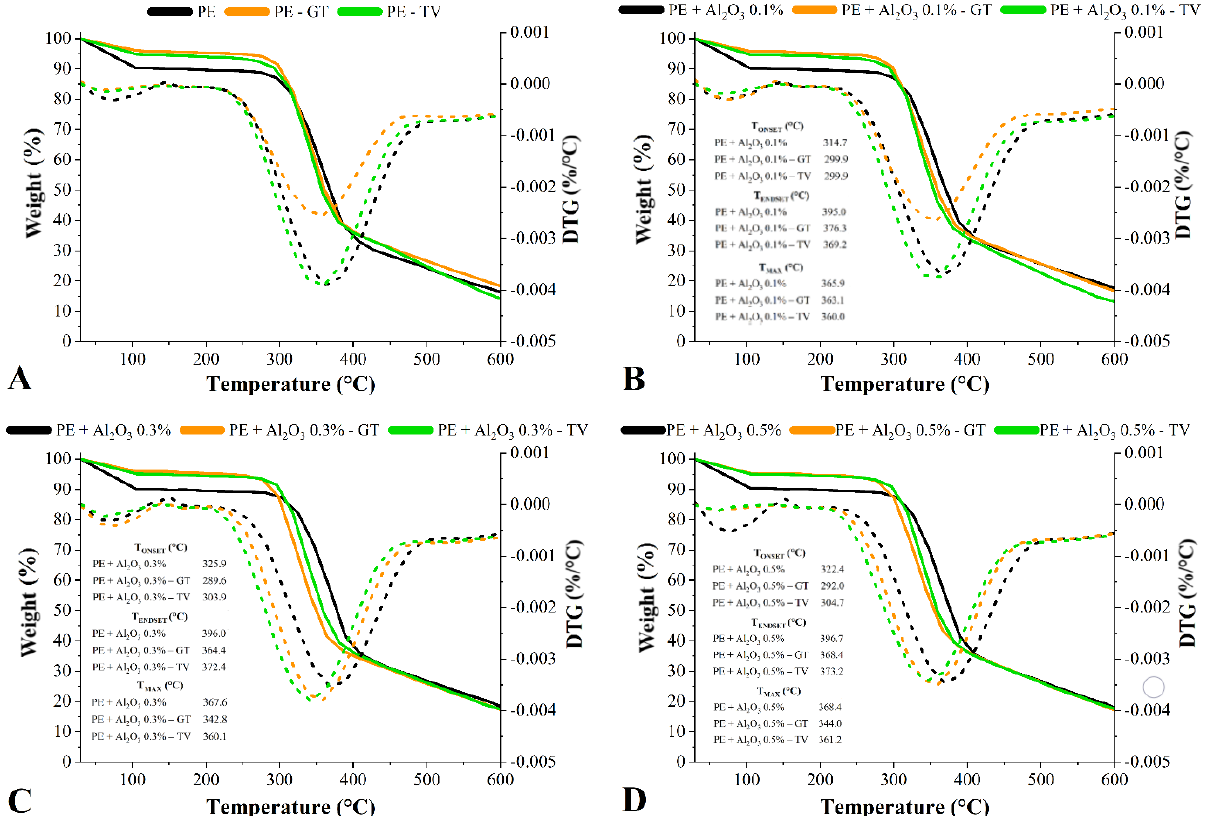
Figure 6. TG curves and main thermal parameters of the treated and untreated P. elliottii (P E ) woods exposed to the G. trabeum ( A , C ) and T. versicolor ( B , D ) fungi.